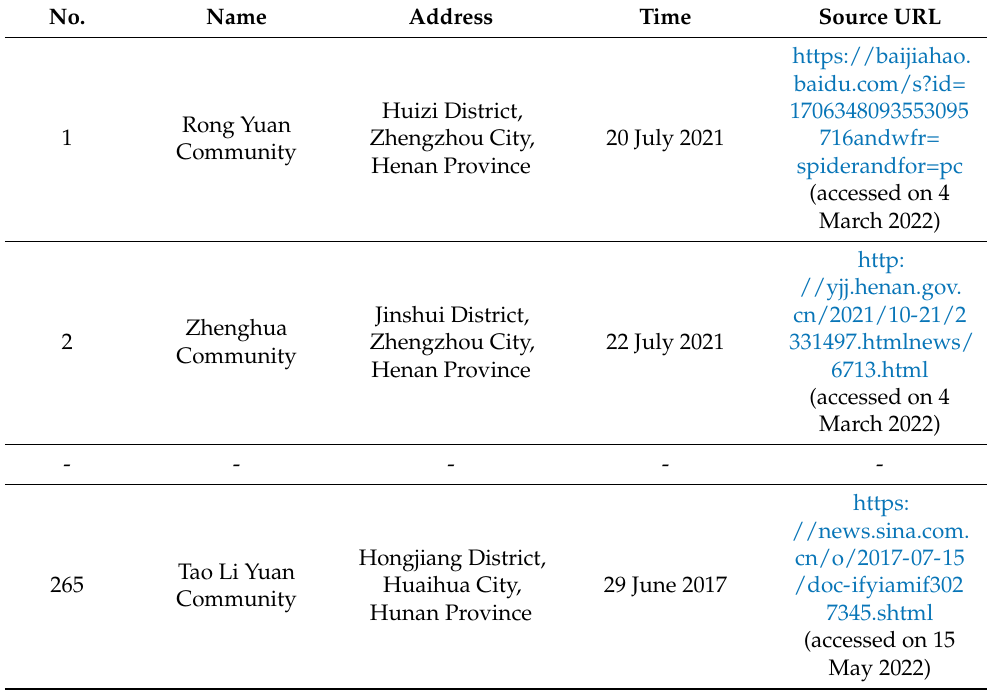
Table 1. Cases of flood-affected urban communities in China, 2017–2021